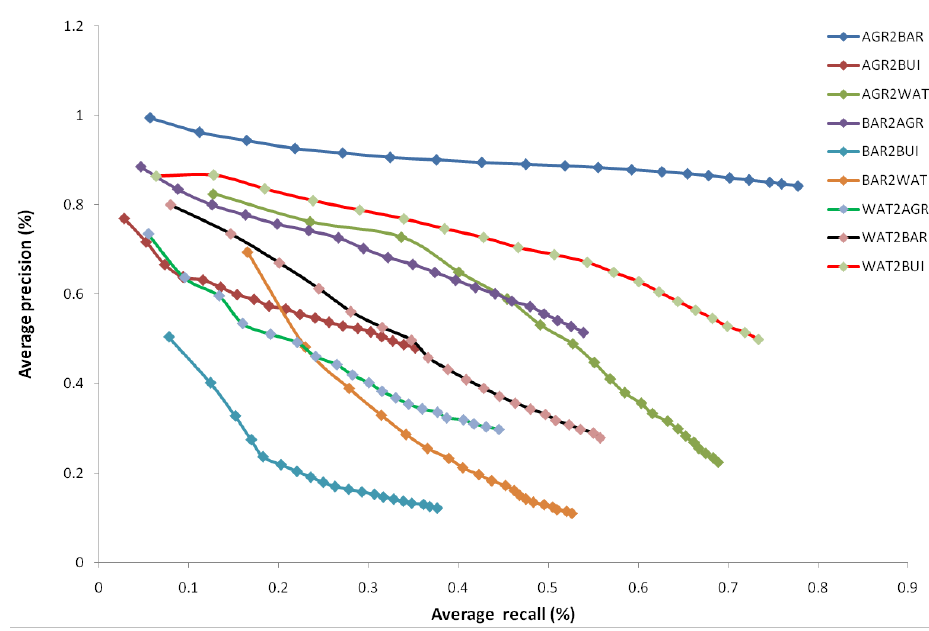
Figure 7. Comparison of the average PVR curve for different ground-change classes.